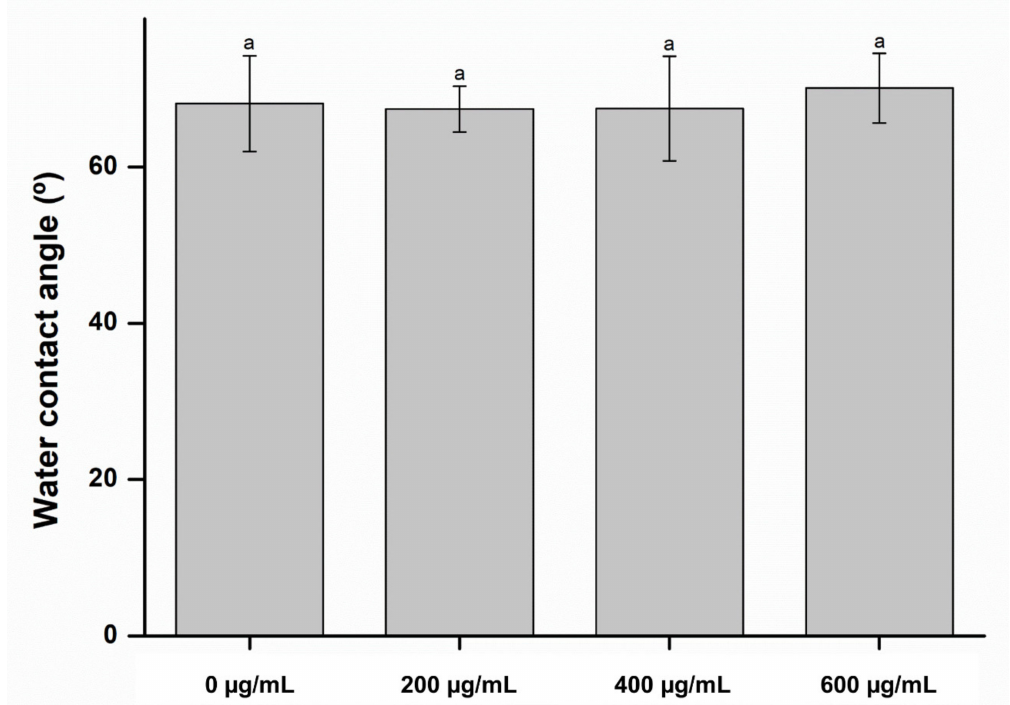
Figure 2. Wettability of the experimental and control groups. Each value represents the mean of five measurements, and the error bar shows the standard deviation of the mean value. The lowercase letter indicates that there were no significant differences between the values of the experimental and control groups ( p >